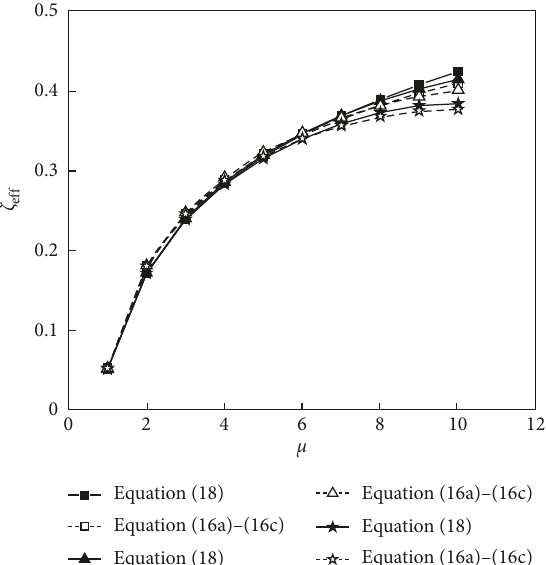
Figure 14: Comparison of EVD ratio predicted by (18) and (16a)– (16c) based on the envelop curves in Figure